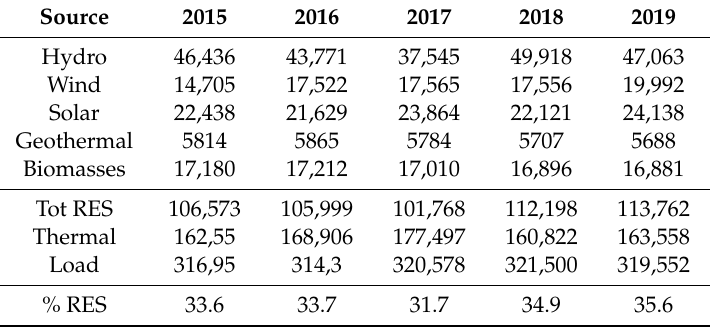
Table 1. Gross electricity production (TWh) from renewable energy sources (RES) in Italy compared to total load.